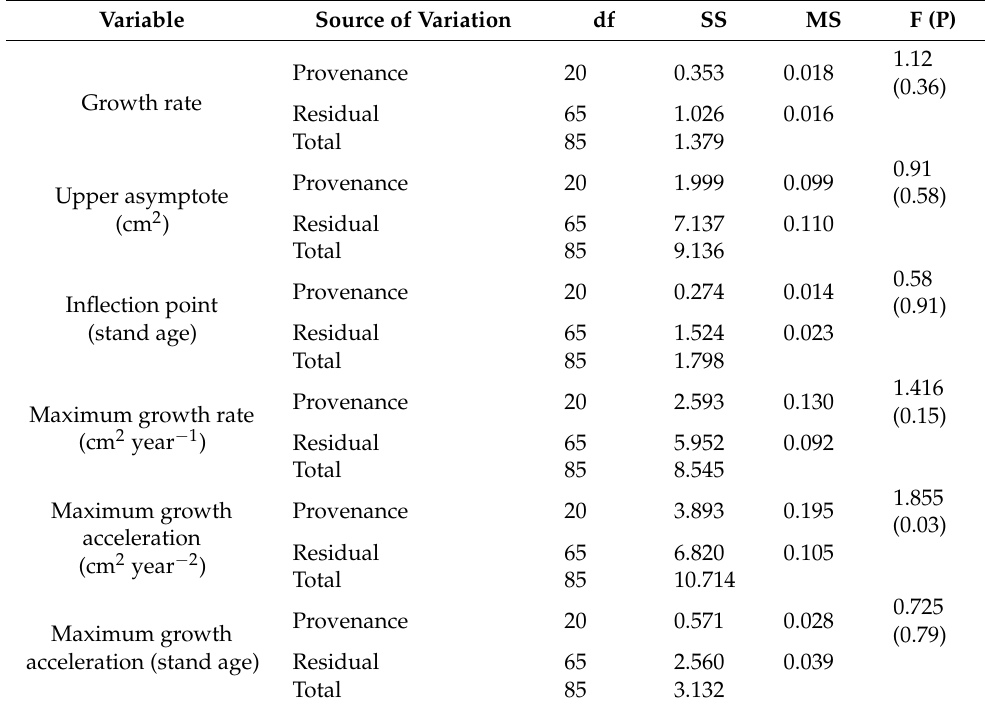
Table 2. Results of the analyses of variance (ANOVA) for the sigmoid growth model parameters and characteristic points of its derivatives from different provenances. After the test statistic F, the probabilities are provided in brackets. Abbreviations: df—degrees of freedom, SS—a sum of squares, MS—mean square.